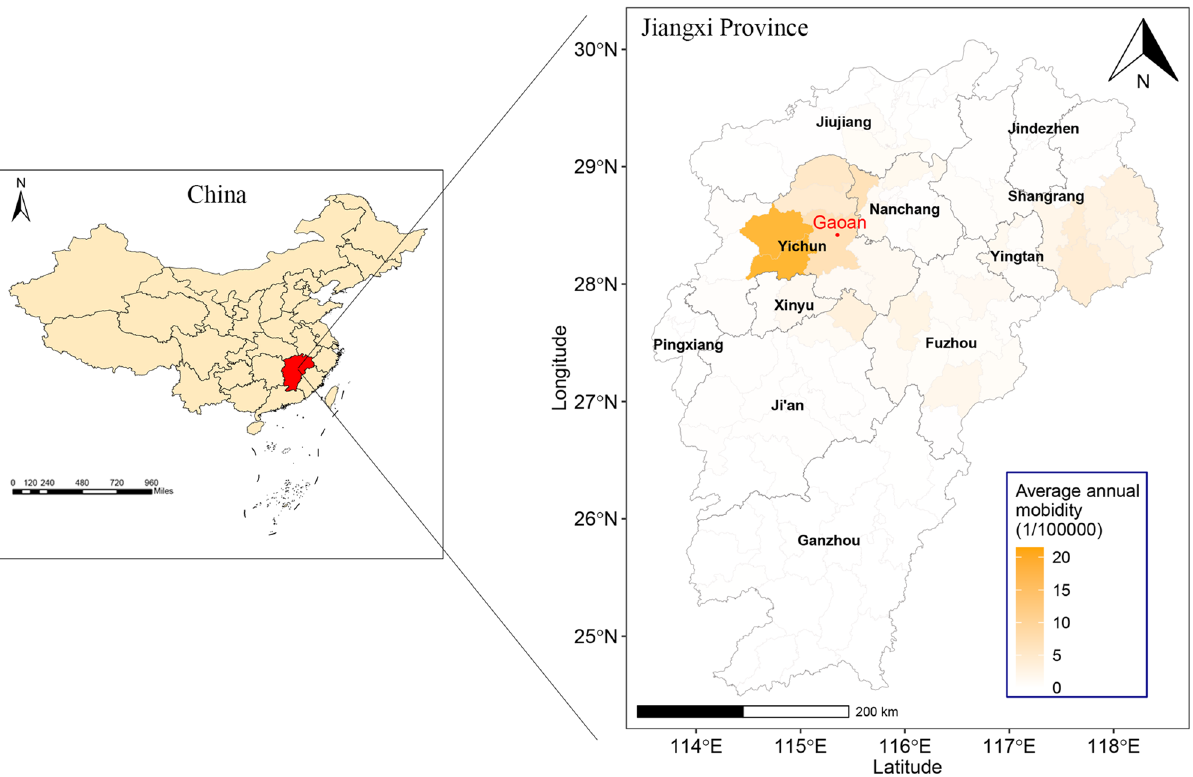
Figure 1. Location of Jiangxi in China and the HFRS morbidity distribution. The map was generated by ArcGIS software (Version 10.4 ESRI, Redlands, CA, USA, https:// www. esri. com/ sofwa re/ arcgis/ arcgis- for- deskt